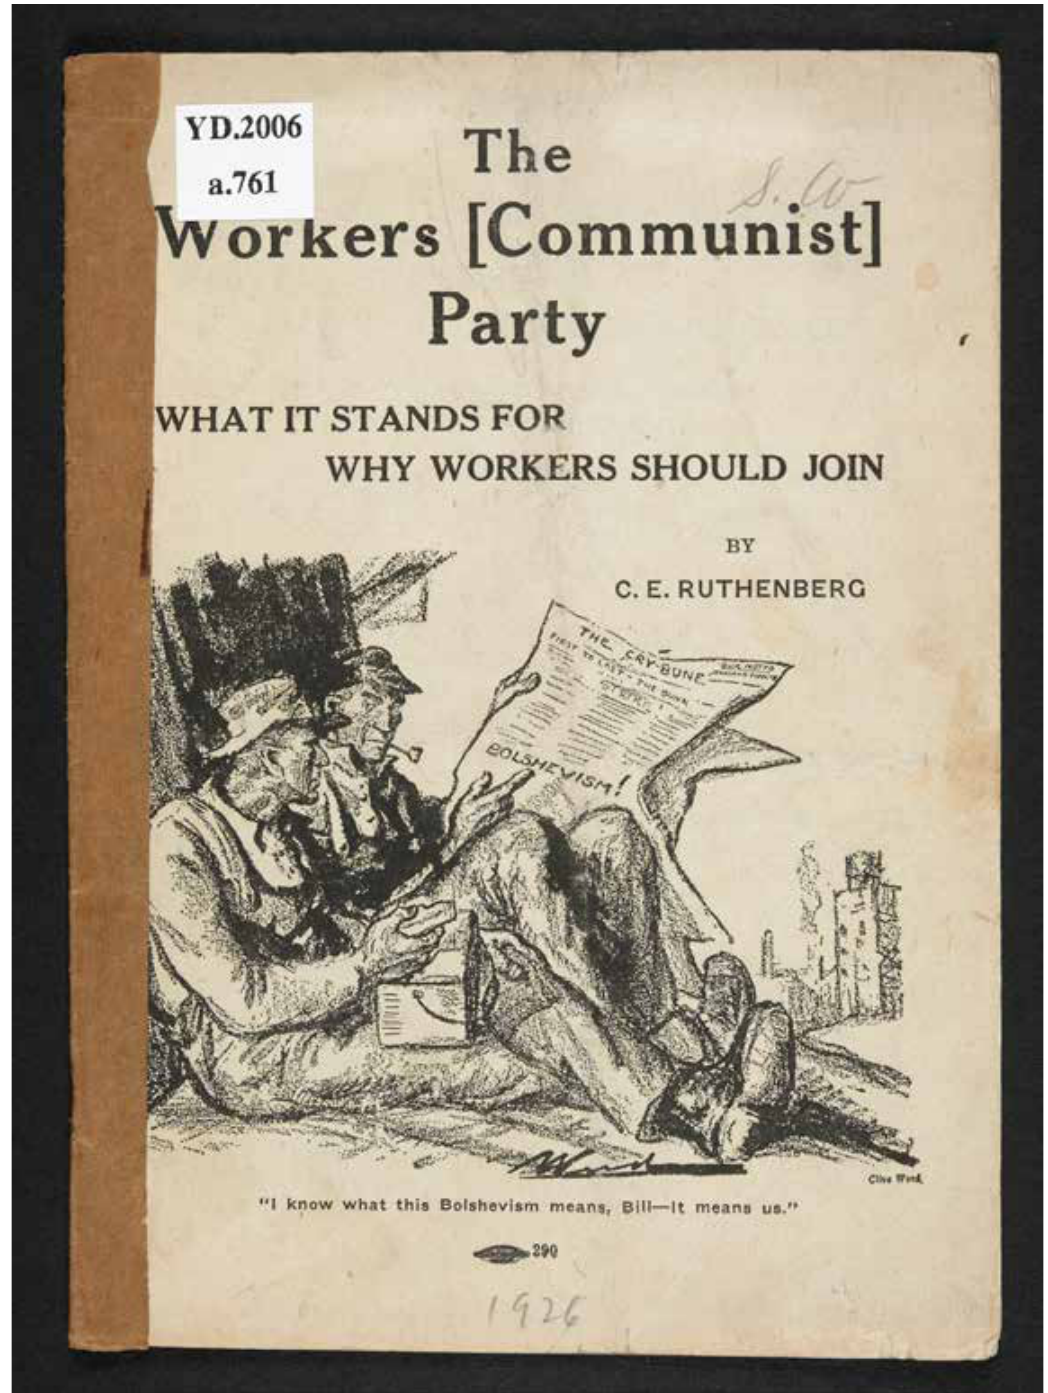
Fig. 2. C. E. Ruthenberg, The Workers [Communist] Party: What It Stands For and Why Workers Should Join (Chicago: The Workers (Communist) Party, 1926). BL,